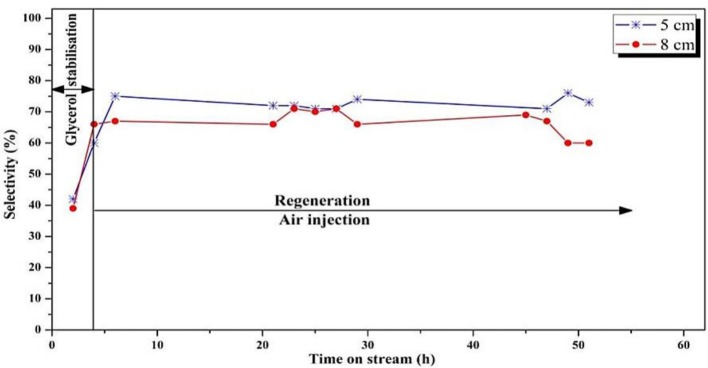
Influence of position of the feed injection nozzle in the fluidized bed on the selectivity to acrolein (T = 275°C, O2/Gly = 0.4, gas velocity = 1.86.10−2 m/s). Five centimeters correspond to Vreaction/Vregeneration = 2 whereas 8 cm correspond to Vreaction/Vregeneration = 1.